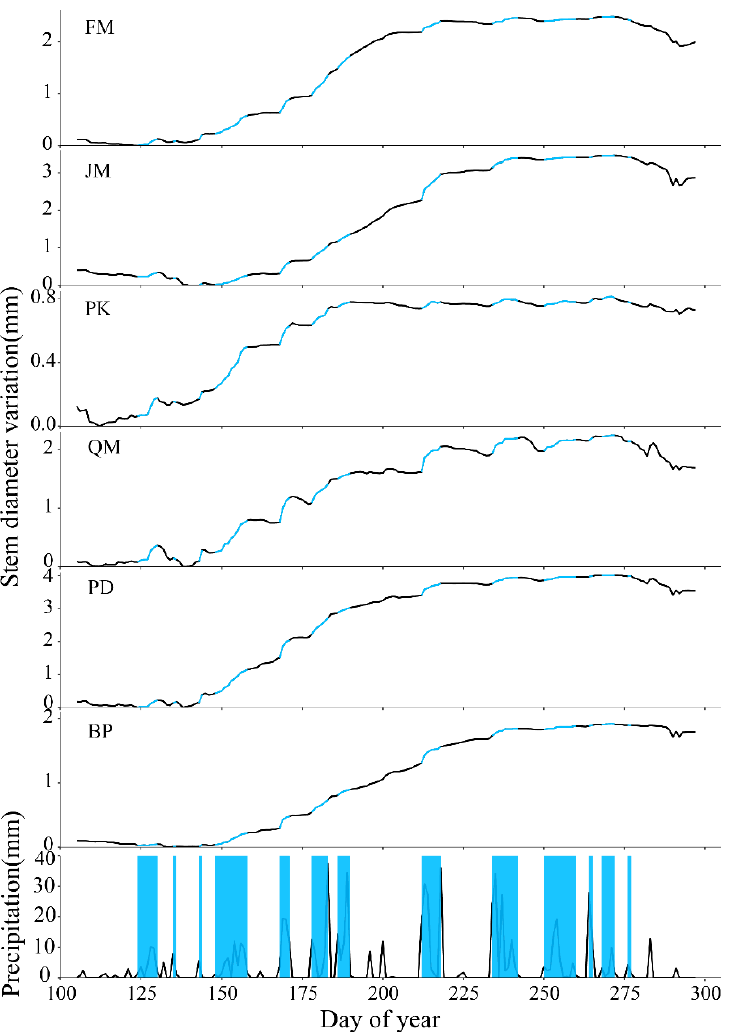
Figure 1. Stem diameter variation of six tree species and precipitation pattern in Northeast China. The shaded part is the time period with two consecutive days of precipitation where the precipitation accumulative amount was greater than 5 mm. The blue part of the annual growth curve is the corresponding stem diameter change during the e ff ective precipitation days of six tree species. FM: